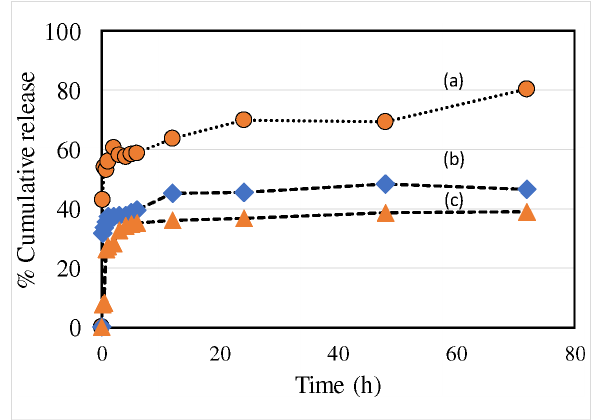
Figure 7: Percentage cumulative cisplatin release in tumor pH 5 condi- tions for 72 h in (a) CuFe 2 O 4 /HYPS, (b) CuFe 2 O 4 /AlMSU-F and (c) CuFe 2 O 4